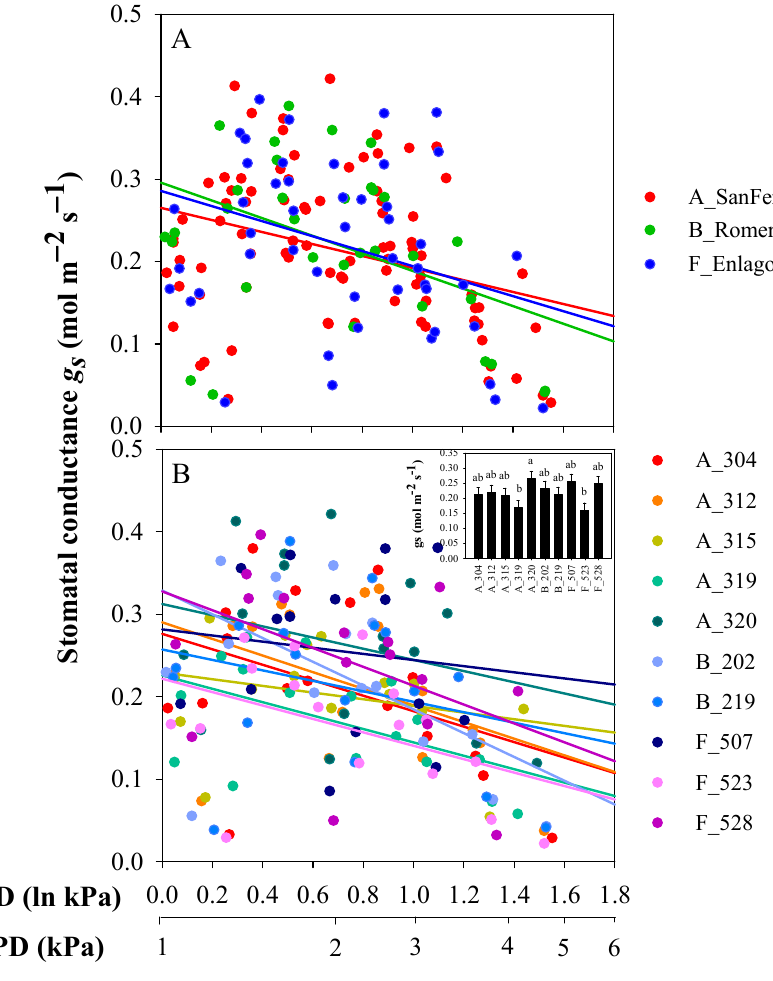
Figure 2. Relationship between stomatal conductance (gs) and the logarithm of VPD in 2-year-old maqui plants ( Aristotelia chilensis (Molina) Stuntz) by provenance ( A ) and by clone ( B ). The VPD scale is also presented. The inset graph shows the average stomatal conductance by clone, and different letters indicate significant differences ( p -value < 0.05) between the genotypes based on Tukey’s means comparison test.